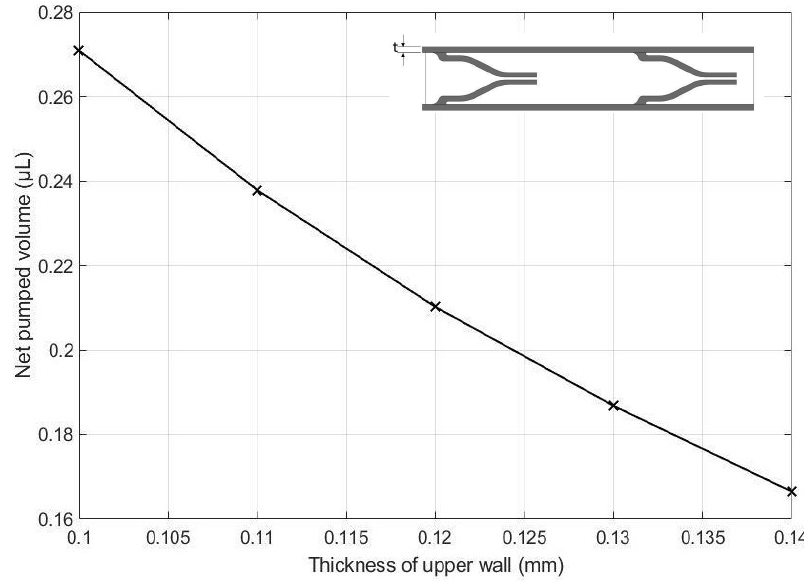
Figure 17. Effect of the thickness of the upper wall on the net pumped volume.